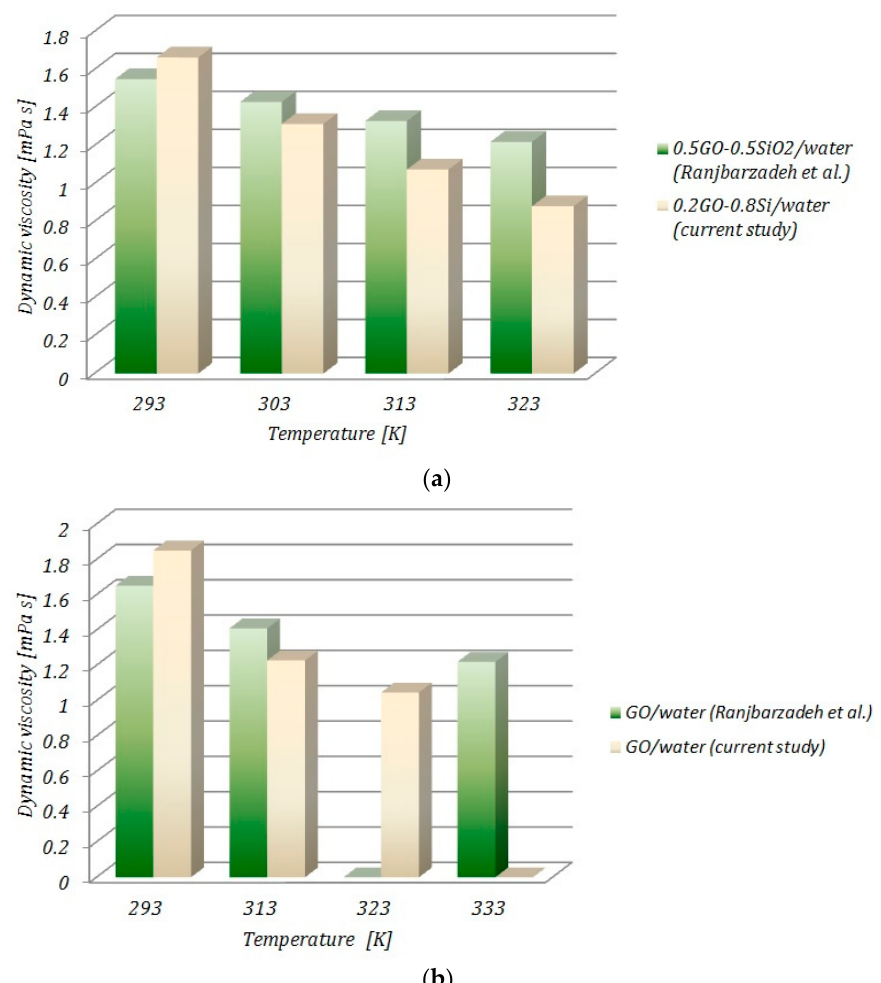
Figure 9. Comparison of the results for ( a ) hybrid nanofluid and ( b ) nanofluid with data from the literature.